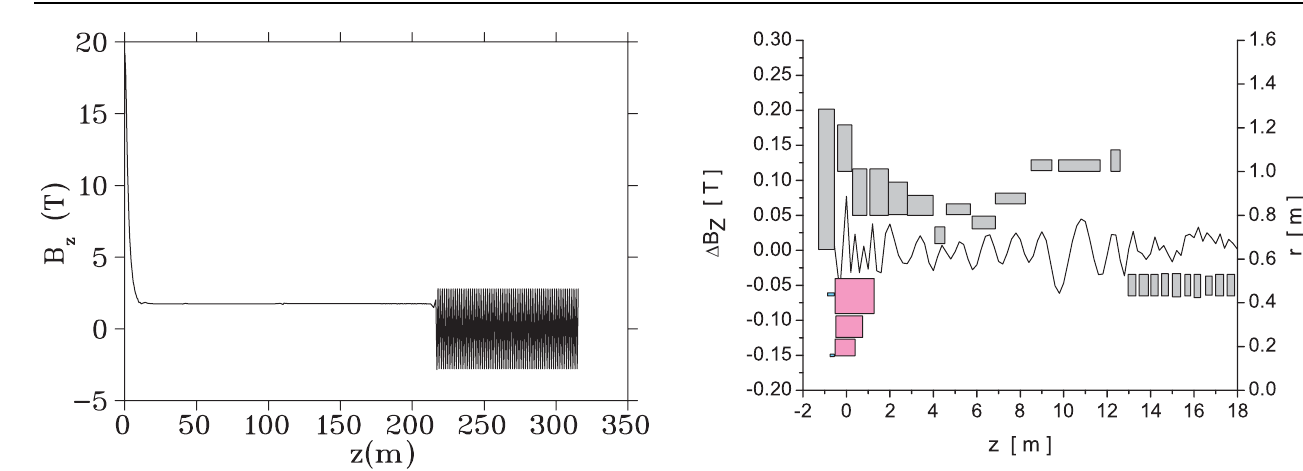
FIG. 5. Longitudinal field component B ST2B front